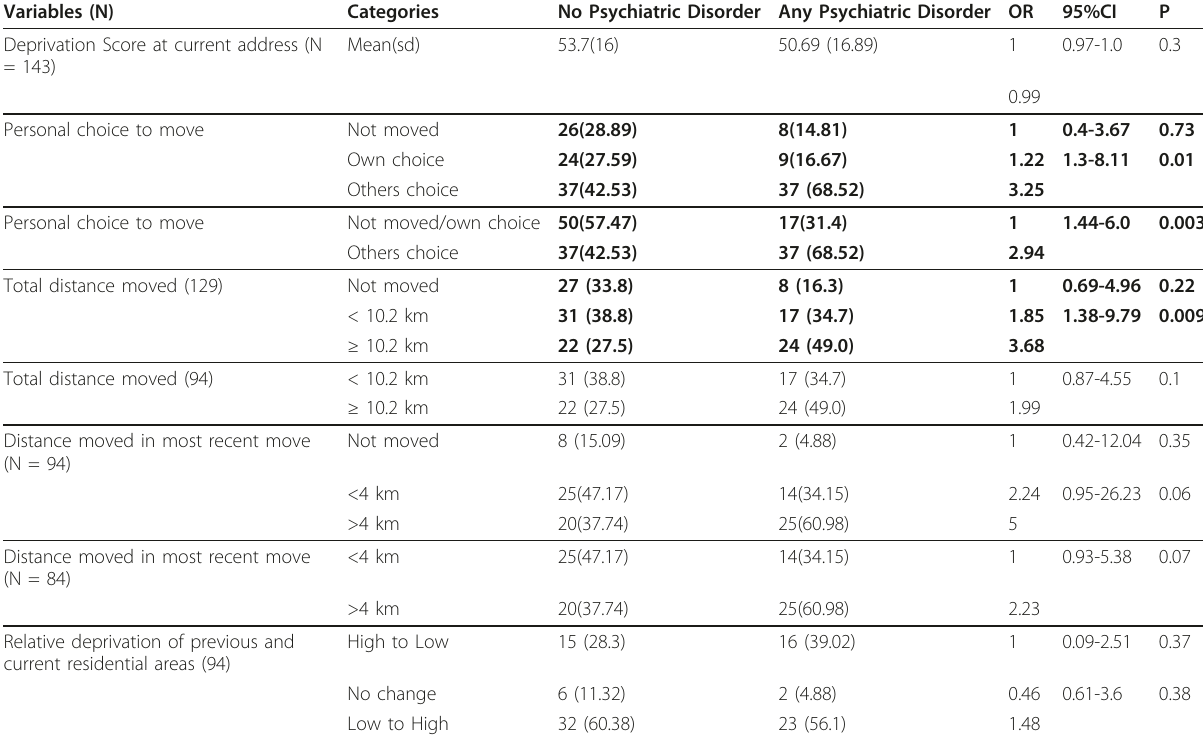
Table 3 Mobility characteristics and psychiatric disorders Variables